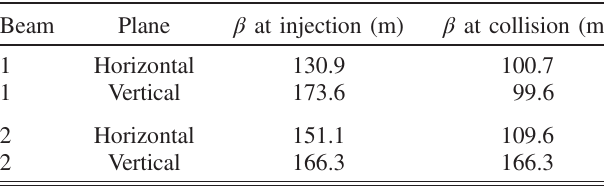
TABLE II. The β -functions at the position of the Q7 pickup per beam and plane with injection and collision optics ( β (cid:1) ¼ 30